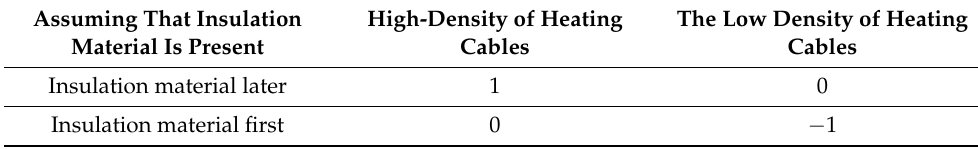
Table 2. Program 2 returns a value according to the density of the heating